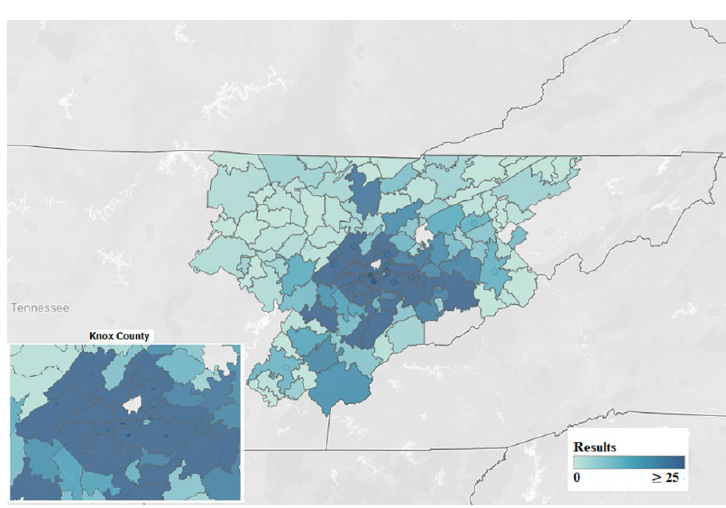
Figure 2 Requests by zip code in hospital’s service